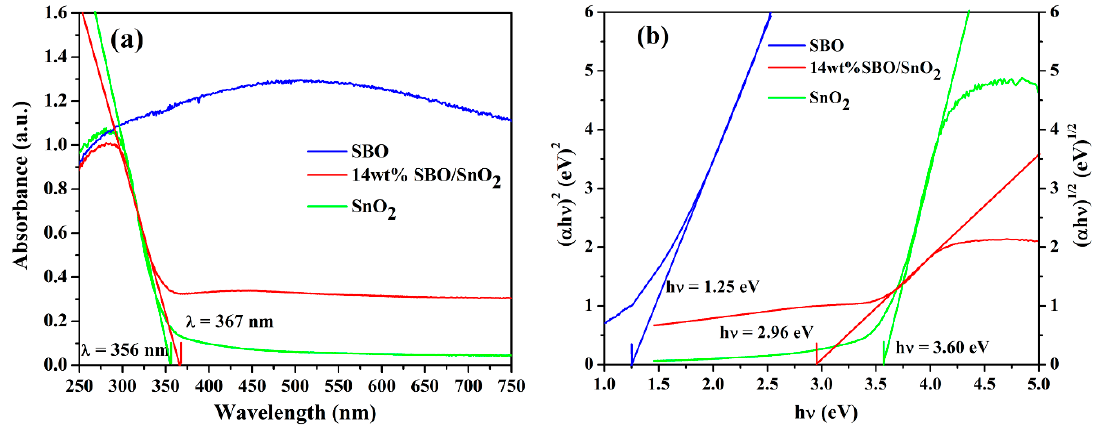
Figure 5. ( a ) UV-vis diffuse reflectance spectra and ( b ) the band gap energy of SBO, SnO 2 , and 14 wt% SBO/SnO 2 composite.